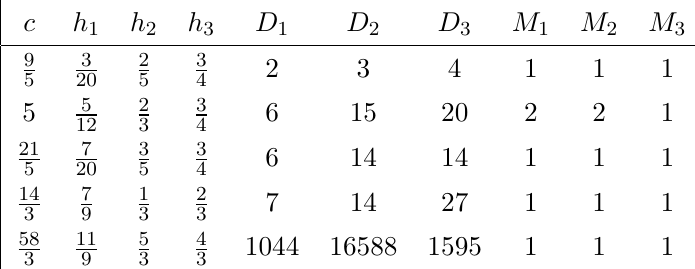
Table 2 . Degeneracies for 4-character coset